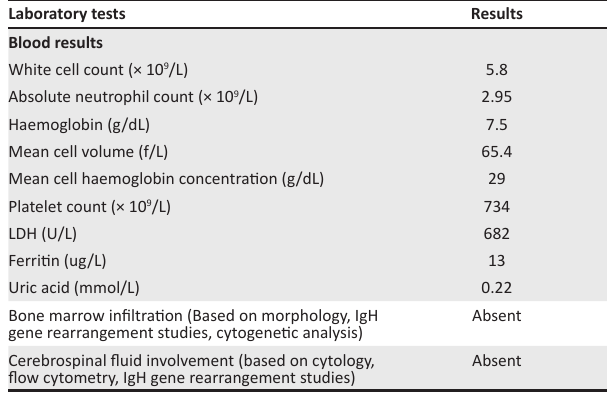
TABLE 1: Laboratory results at presentation of a 9-month-old male patient who presented to the Charlotte Maxeke Johannesburg Academic Hospital in February 2019.